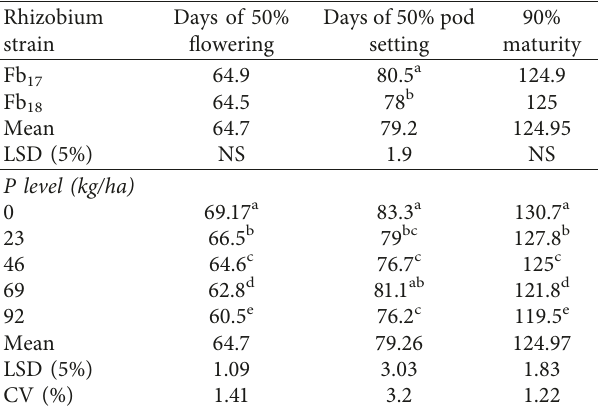
Table 8: Main effects of strain and P fertilizer on 50% days to flowering, pod setting, and 90% day to physiological